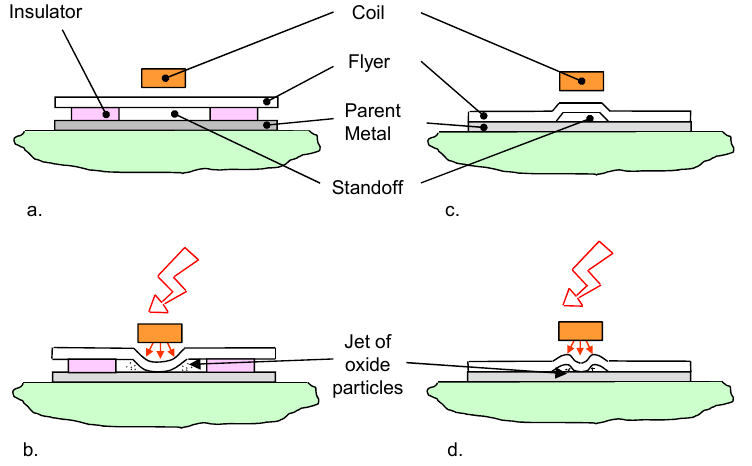
Figure 1. ( a , b ) Magnetic Pulse Welding (MPW)—( c , d ) Magnetic Pulse Spot Welding (MPSW).